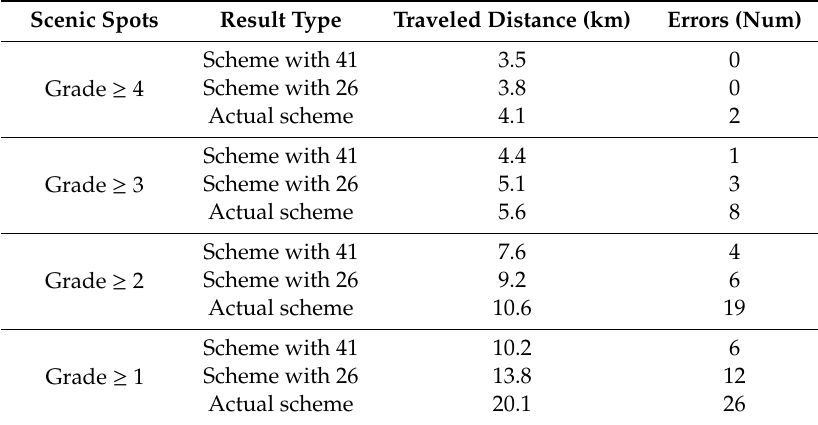
Table 3. The comparison of three schemes in the random walk algorithm.